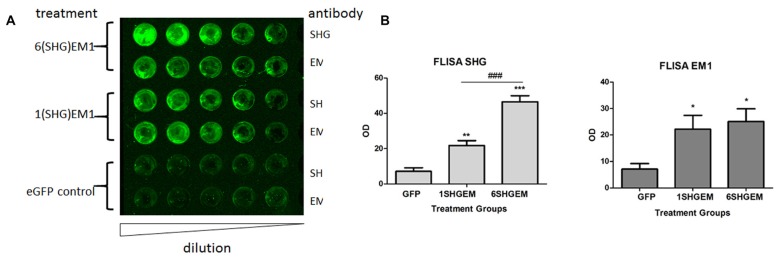
Fluorescence-linked immunosorbent assay (FLISA) analysis of HEK 293 supernatant for the presence of serine histrogranin (SHG) and EM recombinant peptides after transduction with 1SHG/endomorphin1 (EM1), 6SHG/EM1 and GFP gene constructs. (A) SHG and EM1 peptides detected in samples from compound gene constructs transduced cell cultures. No signal detected in the control samples from GFP transduced cells. (B) The level of SHG in 6SHG/EM samples was significantly higher than in 1SHG/EM samples as expected. The level of EM was comparable between samples (ANOVA; *p < 0.05, **p < 0.01, ***p < 0.001 vs. GFP control; ###p < 0.001 for 6SHG/EM vs. 1SHG/EM).